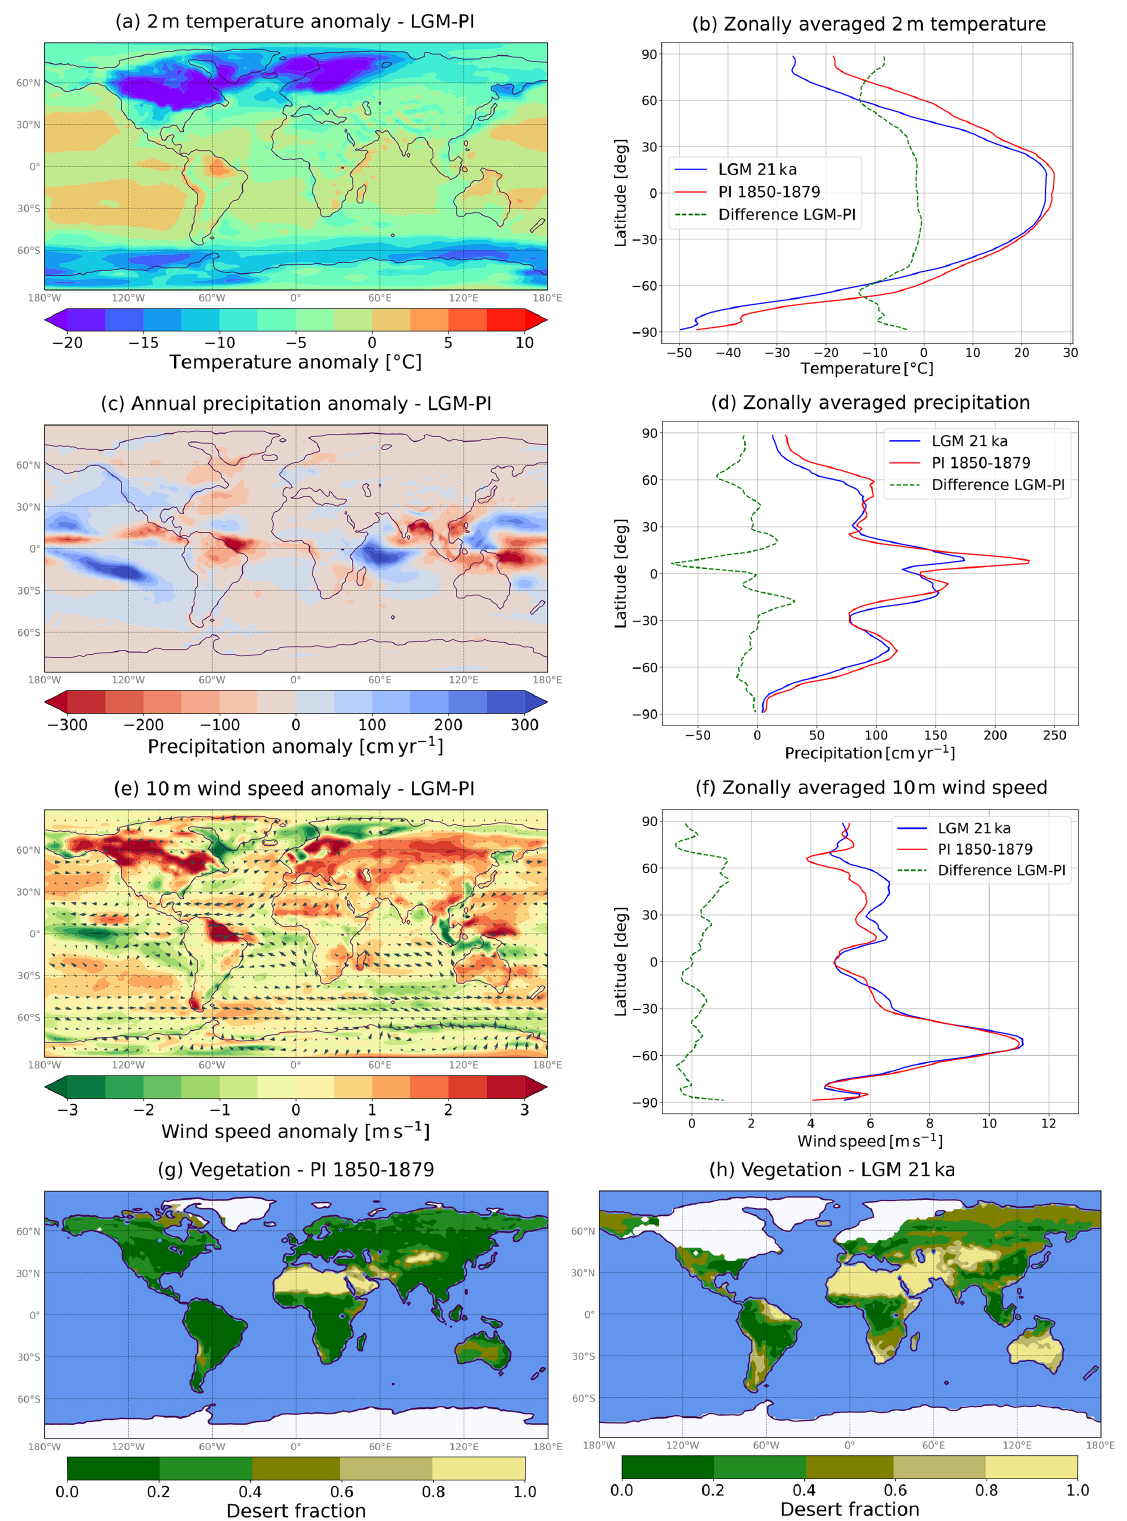
Figure 2. Global maps and zonally averaged graphs of anomalies (LGM − PI) in the 2m temperature (a, b) , annual precipitation (c, d) , 10m wind speed (e, f) , and desert fraction for each grid box for both PI and LGM (g, h) . Please note that glaciers (white) and the ocean (blue) have been colored in (g) and (h) for improved